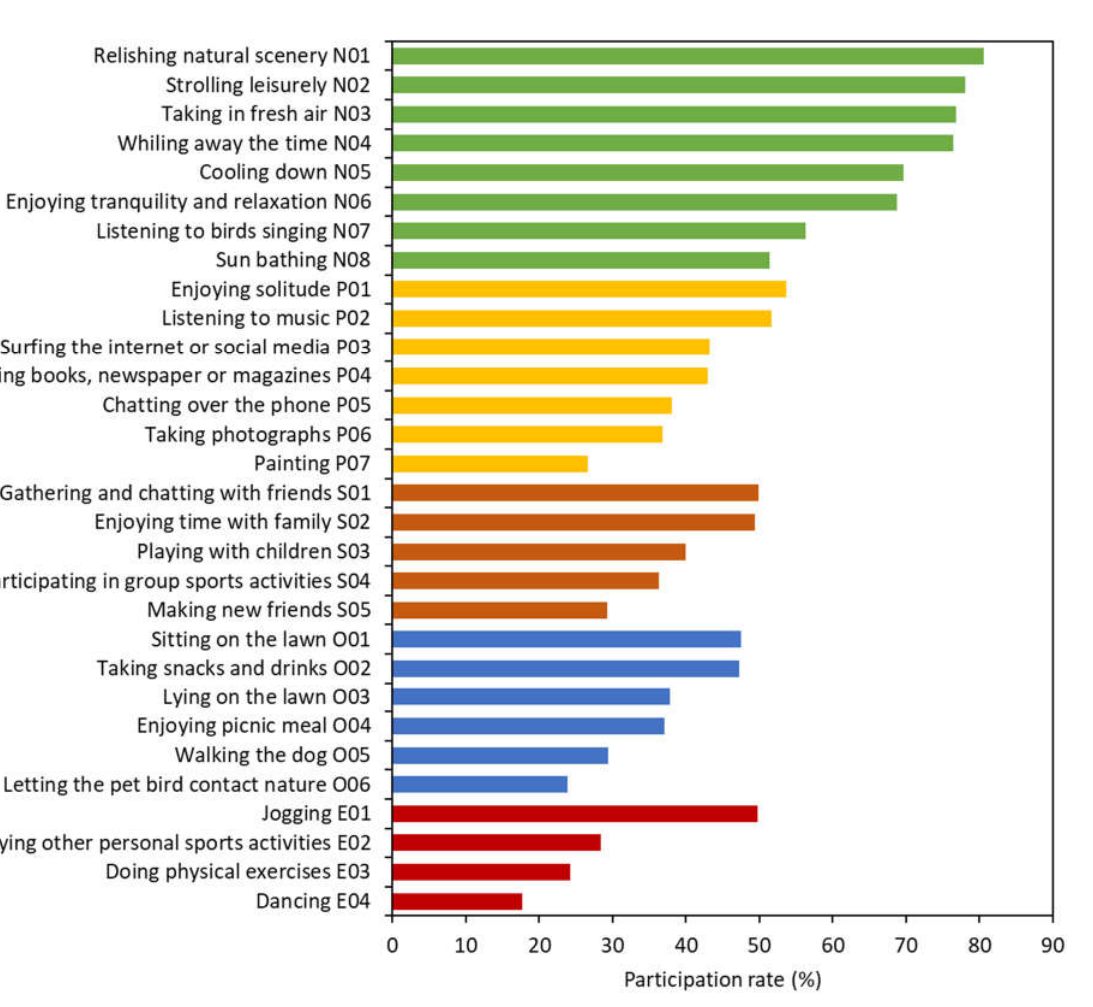
Figure 3. The participation rate (percentage of respondents answering “Frequent” or “Occasional”) in 30 activity types grouped into five activity clusters: N for nature-enjoyment cluster, P for personal cluster, S for social cluster, O for outdoor cluster, and E for physical-exercise cluster.